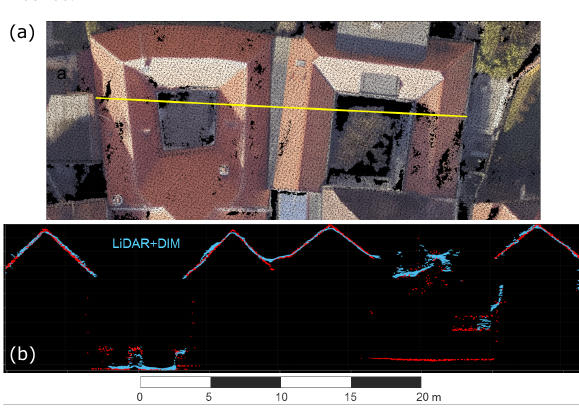
Figure 7. Color coded height differences LiDAR vs. DIM before (a) and after (b) simultaneous orientation of scans and images meshes.